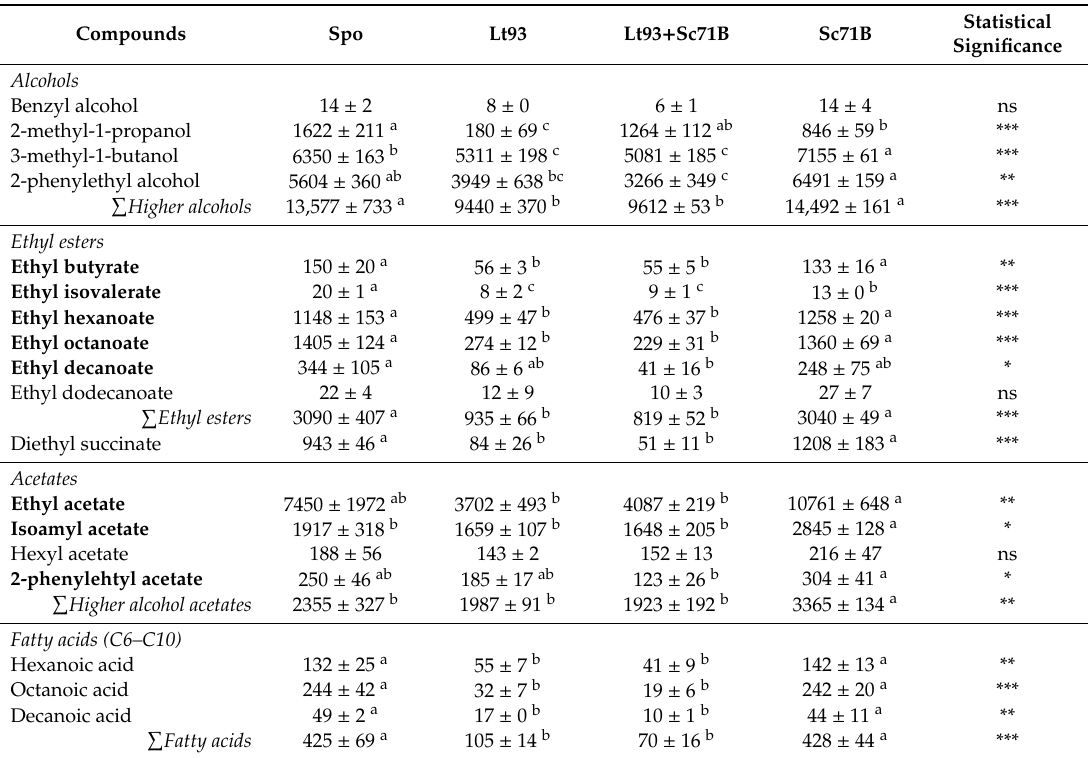
Table 5. Concentration of volatile compounds (expressed in µ g / L) in Menc í a wines elaborated with S. cerevisiae Sc71B, L. thermotolerans Lt93, sequential fermentation of both strains and by spontaneous fermentation